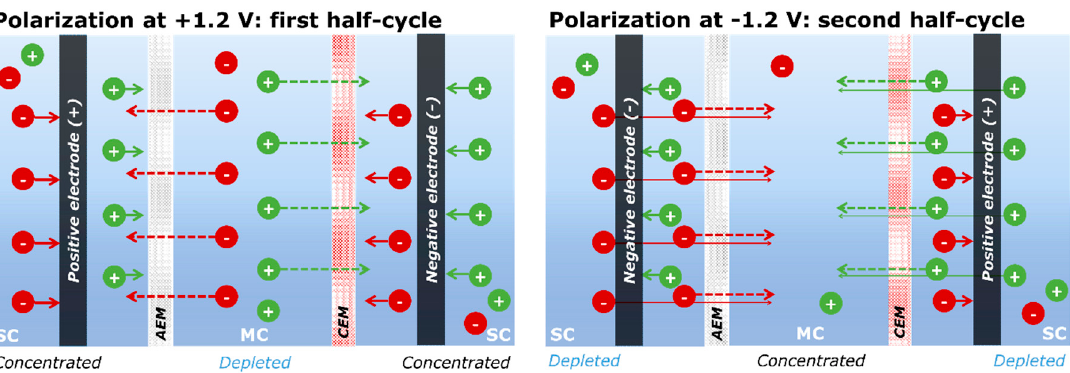
Figure 7. Ion removal mechanism of MC-MCDI in semi-continuous operation: Anion exchange membrane (AEM) and cation exchange membrane (CEM), and MC and SC denote the middle and side channels, respectively. (Reprinted with permission from Reference [32]).